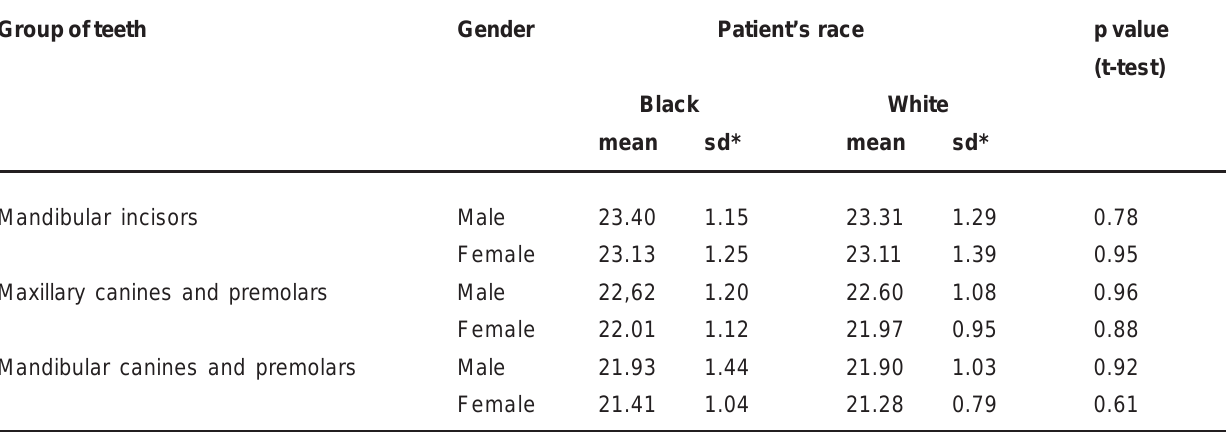
TABLE 1- Combined mesiodistal crown width of mandibular incisors and of canines and premolars according to patient’s gender and race, in millimeters